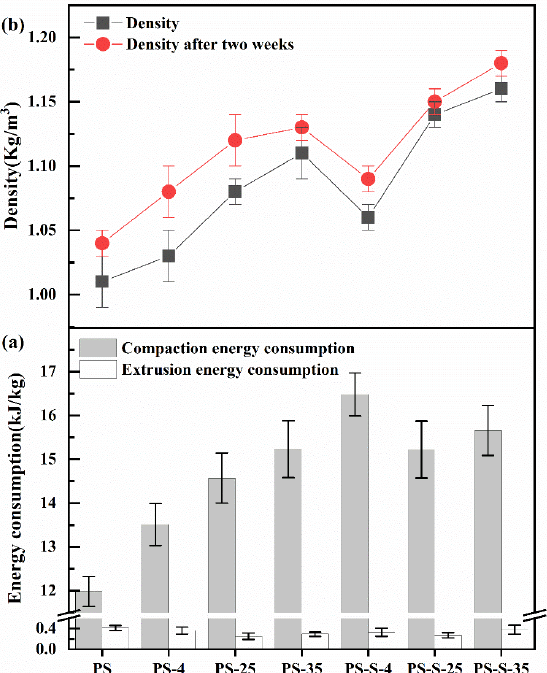
Figure 6. ( a ) Energy consumption for pelletization, ( b ) single pellet density of PS, PS-4, PS-25, PS-35, PS-S-4, PS-S-25, and PS-S-35.